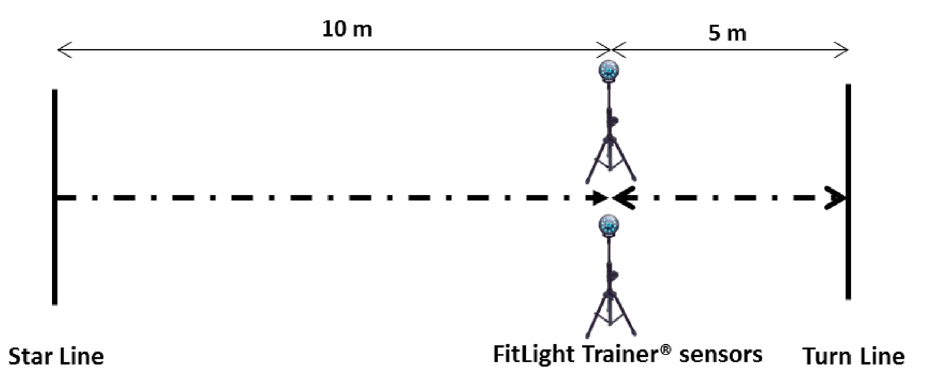
Figure 3. Set up for the 505 COD